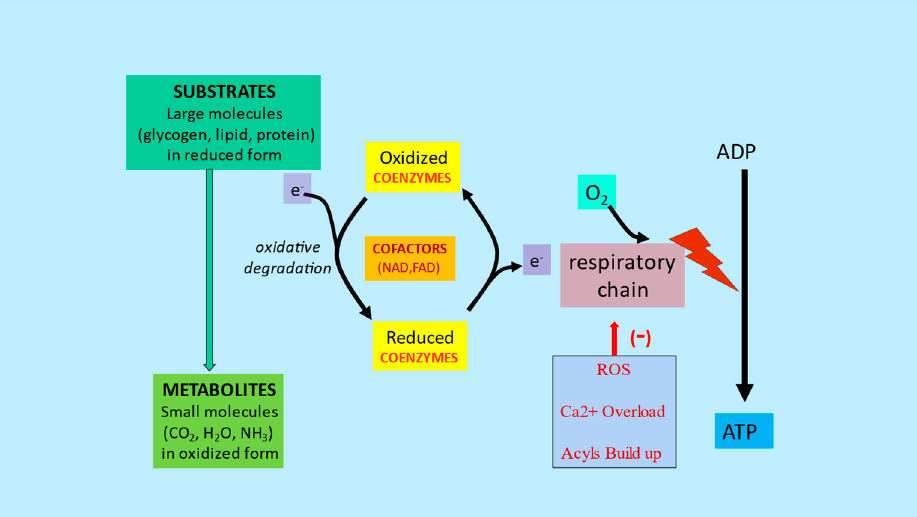
Figure 6. Substrates and nutrient cofactors in mitochondrial function and metabolic flexibility. Adapted from Virmani et al., 2013 [27]. Energy from starting substrates such as glycogen, lipids, and proteins are gradually extracted by the complex series of enzymes in the cellular cytoplasm and mitochondria, resulting in metabolites, mainly CO 2 and H 2 O. Any dysfunction in this chain of events caused by lack of cofactors or mitochondrial dysfunction would lead to reduced ATP formation and increased ROS, Ca 2+ and acyls buildup.